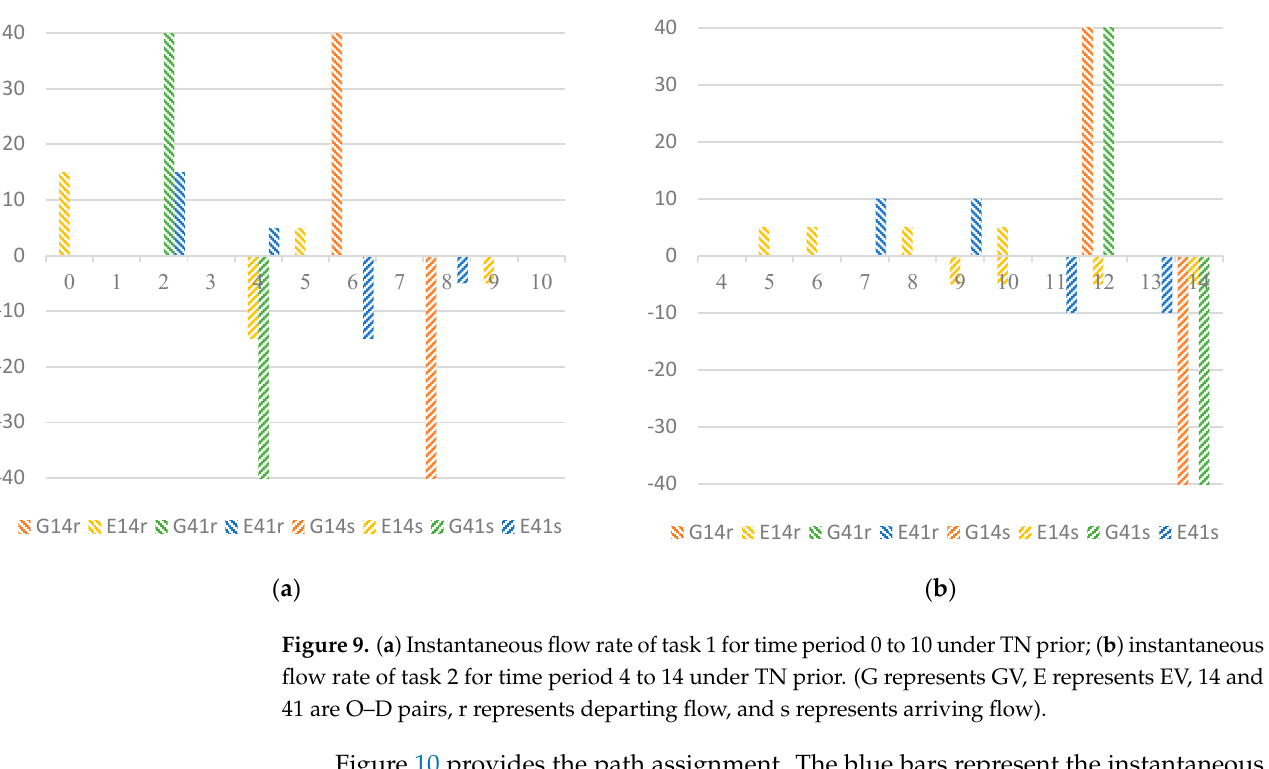
Figure 10. Path assignment of EVs of 2 tasks h (TN prior, T = 14).